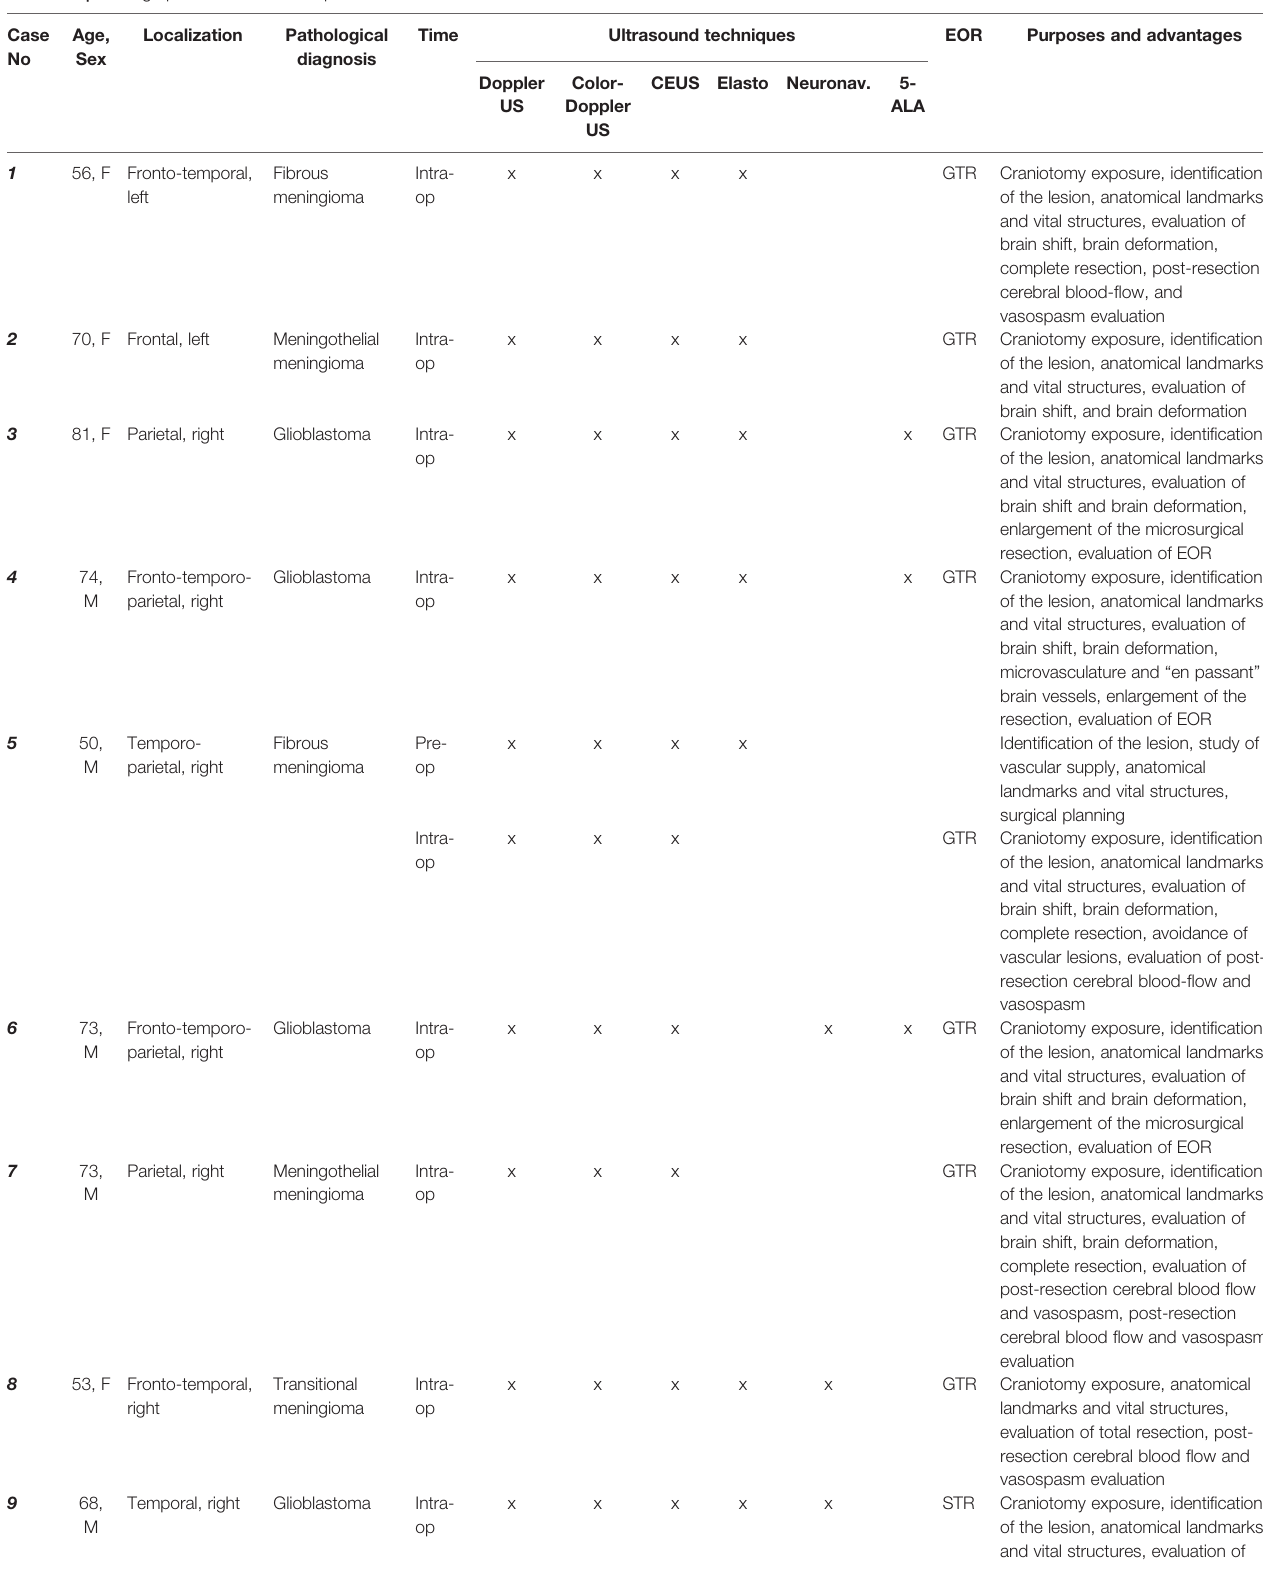
TABLE 1 | Demographic data of enrolled